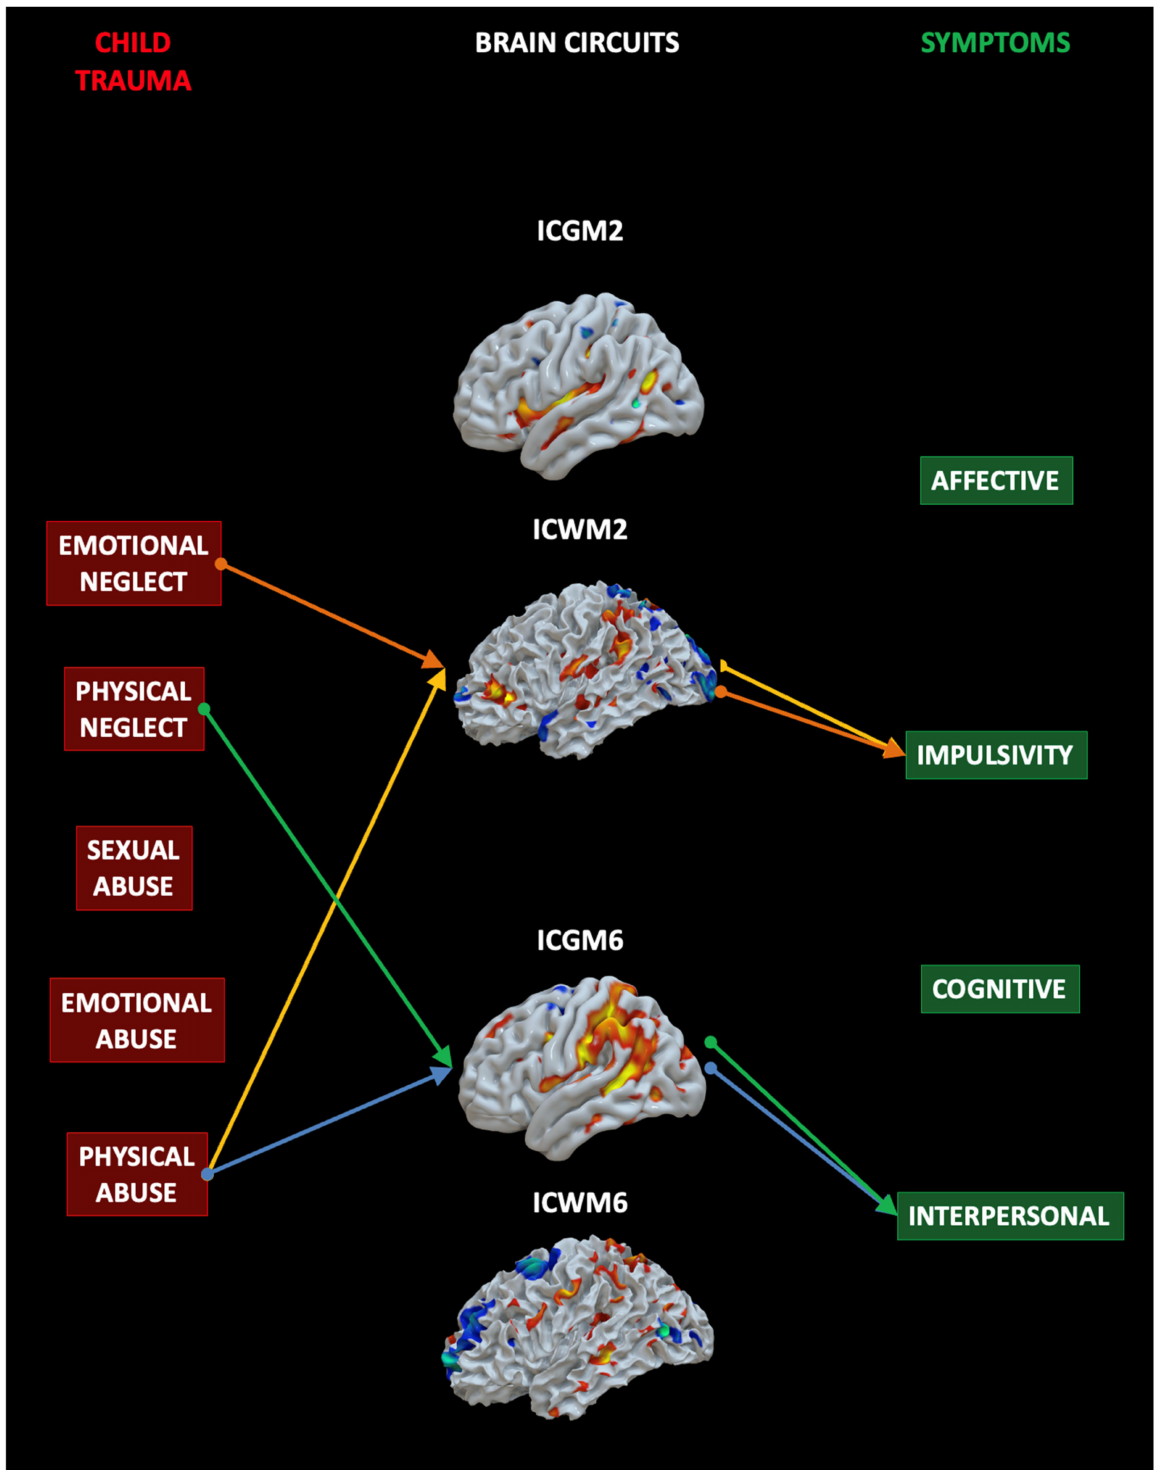
Figure 6. Mediation analysis results . Emotional neglect and physical abuse predicted the IC2 (WM) network and that this in turn predicted symptoms in the impulsivity domain. Physical neglect and abuse predicted IC6 (GM) and this in turn predicted interpersonal symptoms. The colors indicate the same indirect effect linking a given child trauma (IV) to a specific symptom (DV) mediated by a specific IC